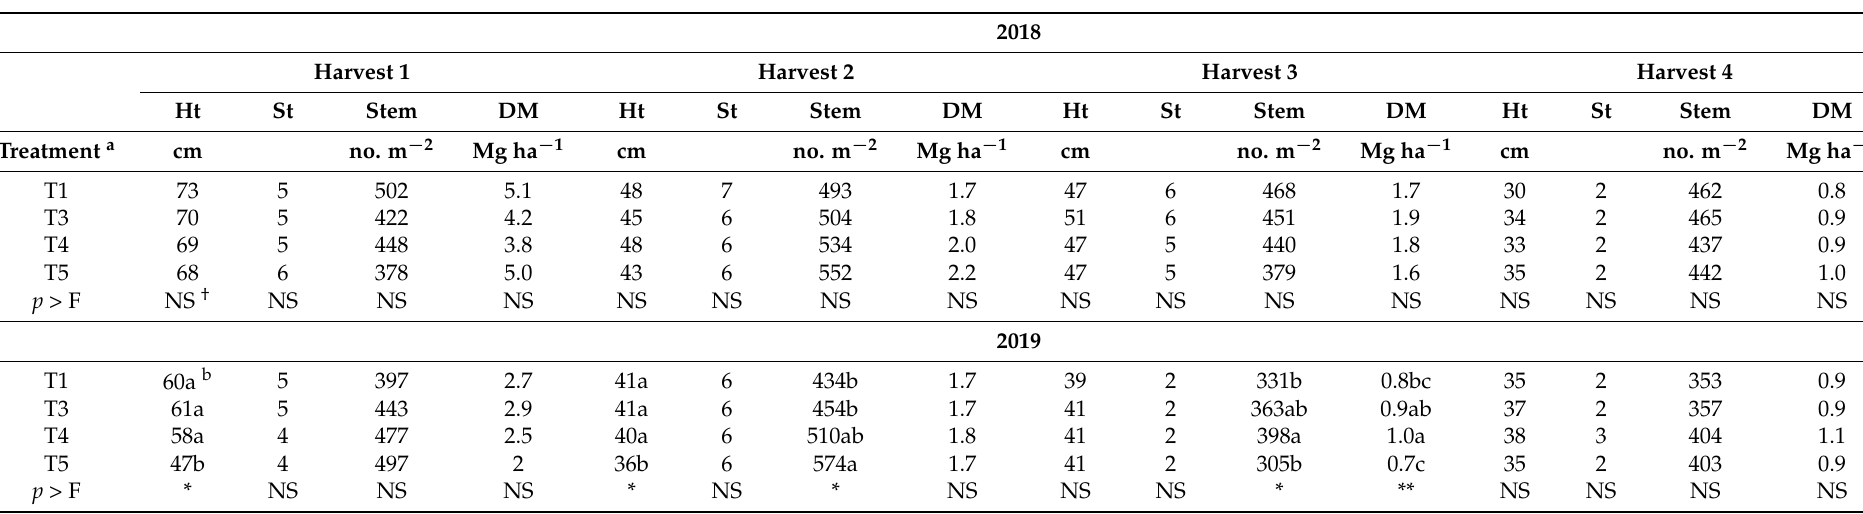
Table 9. Alfalfa stem height (Ht), growth stage (St), stem density (Stem) at each harvest, and total seasonal dry biomass for second production year of alfalfa in 2018 and